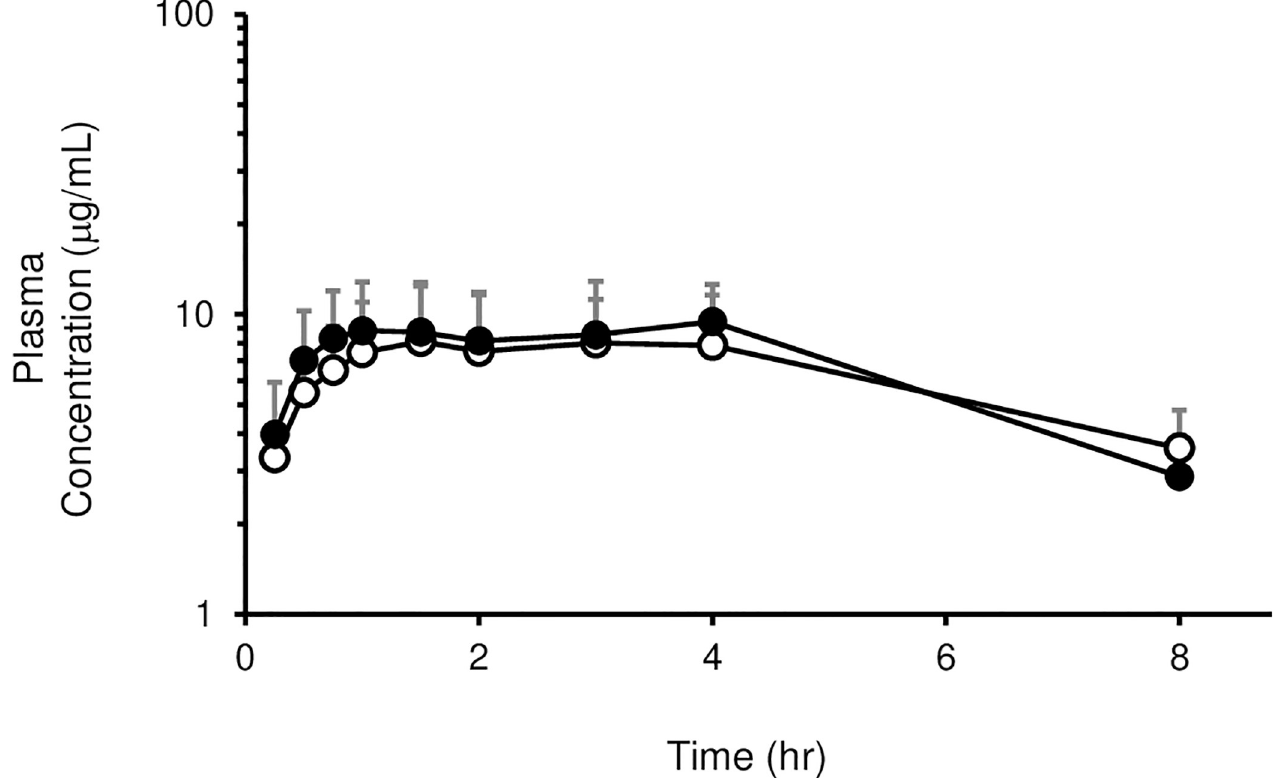
Fig 2. Serum concentration-time courses of CBZ after staggered oral administration with RASS. Serum concentrations of CBZ were measured after oral administration with RASS. Results are shown as the means ± SD of five rats per group. Open circles: short-term group; Closed circles: long-term group.